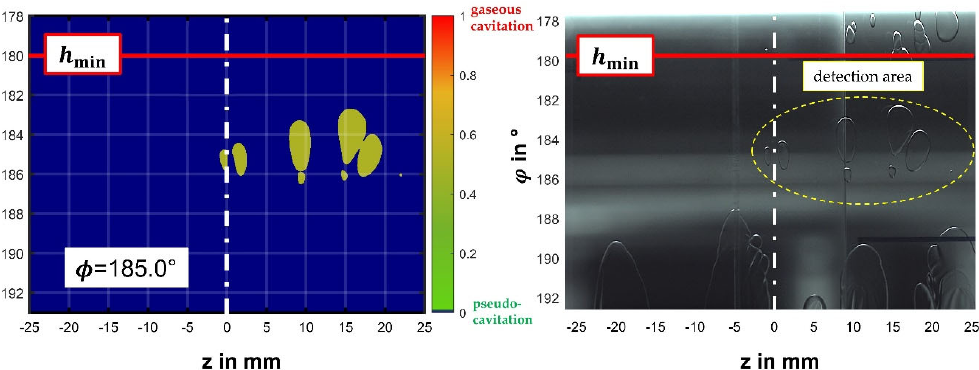
Figure 13. Phase 2: bubble growth due to simultaneous gas and pseudo-cavitation, rotational angle φ = 185.0 ◦ after initiation of transient radial displacement, fluid: paraffin containing 100% dissolved air.